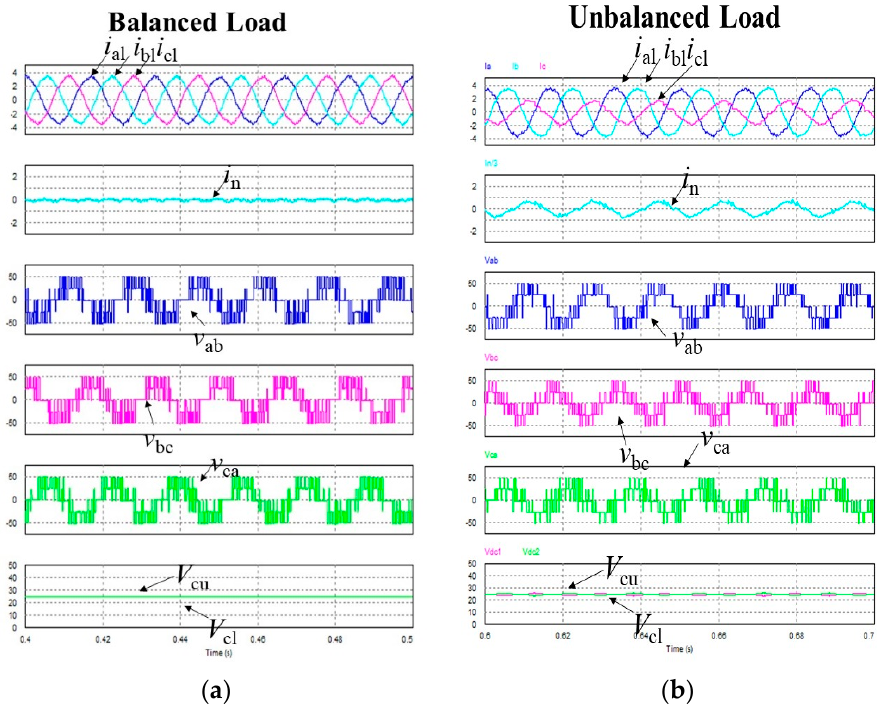
Figure 9. Simulation output performance of a three-level four-leg inverter with model predictive control under ( a ) balanced and ( b ) unbalanced load conditions with same input condition of experiment.